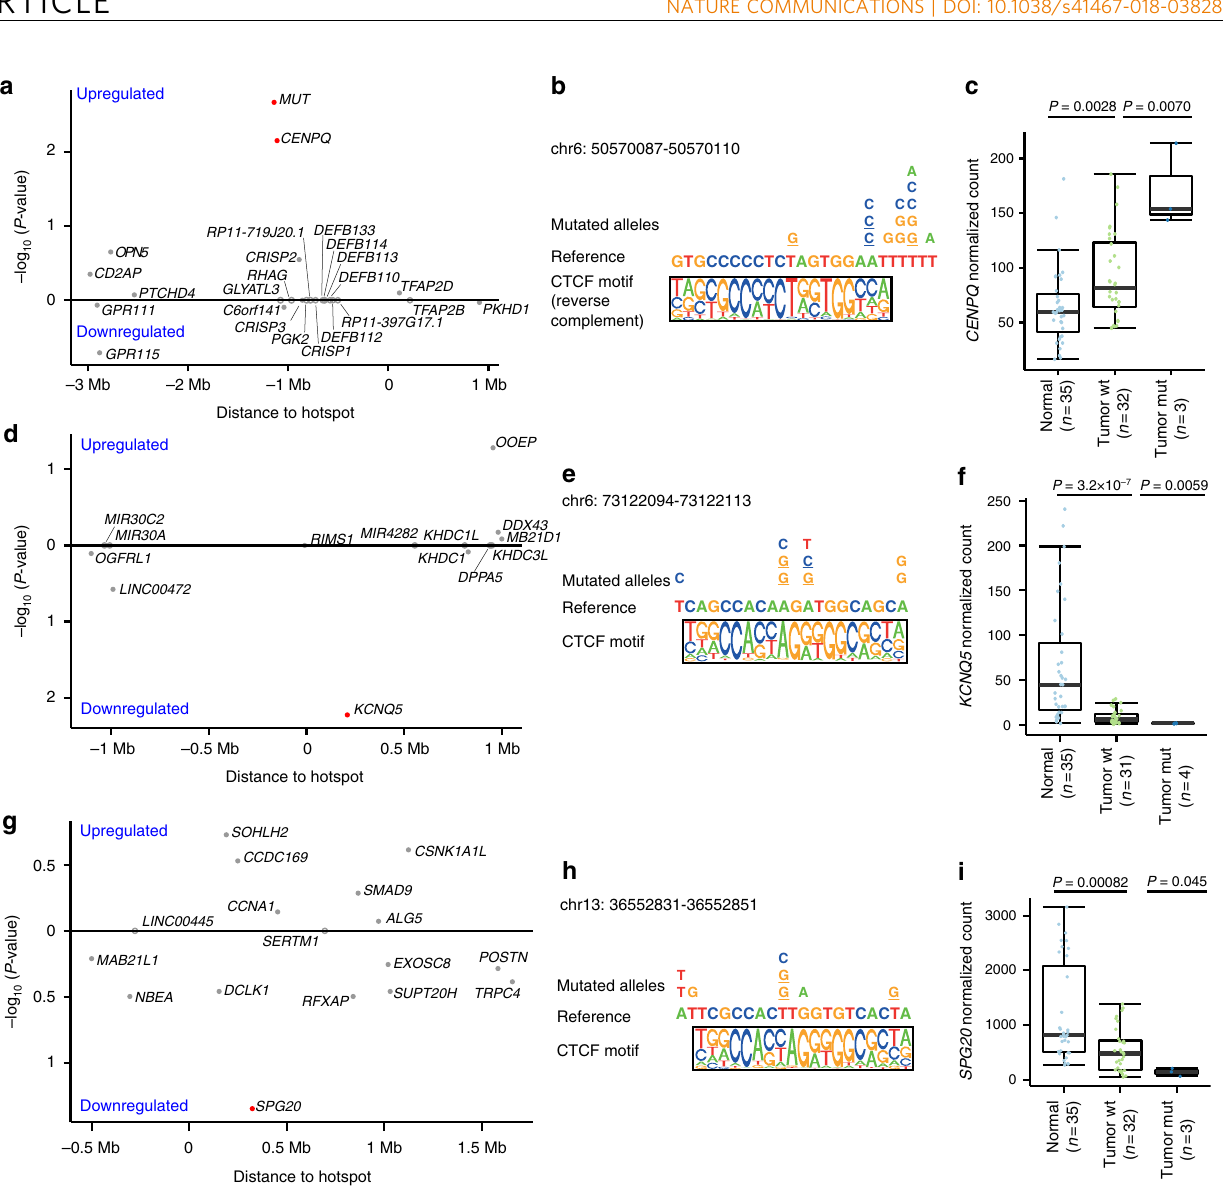
Fig. 5 Association of CBS hotspot mutations and cis-gene expression. a , d , g Association between mutation status of the CBS hotspot and expression levels of neighboring genes (two-sided Wilcoxon rank-sum test). Upregulated genes are shown above the x -axis, and downregulated genes are shown below the x -axis. Non-expressed genes are shown with empty circles on the x -axis (normalized count < 10 in all samples). b , e , h The reference sequence and mutated alleles at the three CBS hotspots. The mutations in tumors with expression data are underlined. c , f , i The gene expression of CENPQ ( c ), KCNQ5 ( f ), and SPG20 ( i ) in normal gastric tissue, and tumors with and without mutations at the corresponding CBS hotspot. P -values were adjusted using